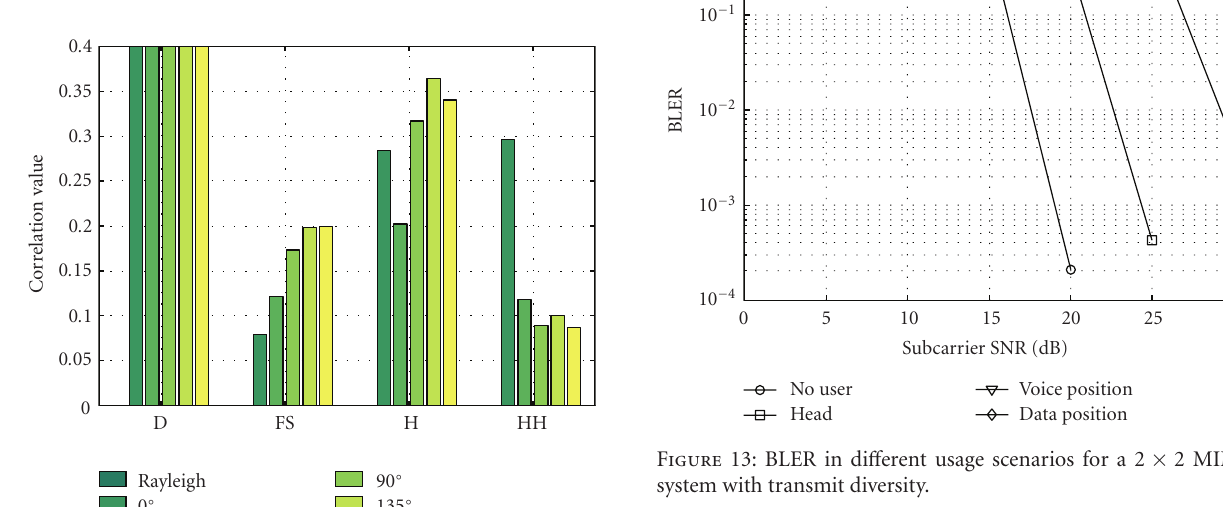
Figure 10: Average channel power factor in the di ff erent usage scenarios at di ff erent user orientations.